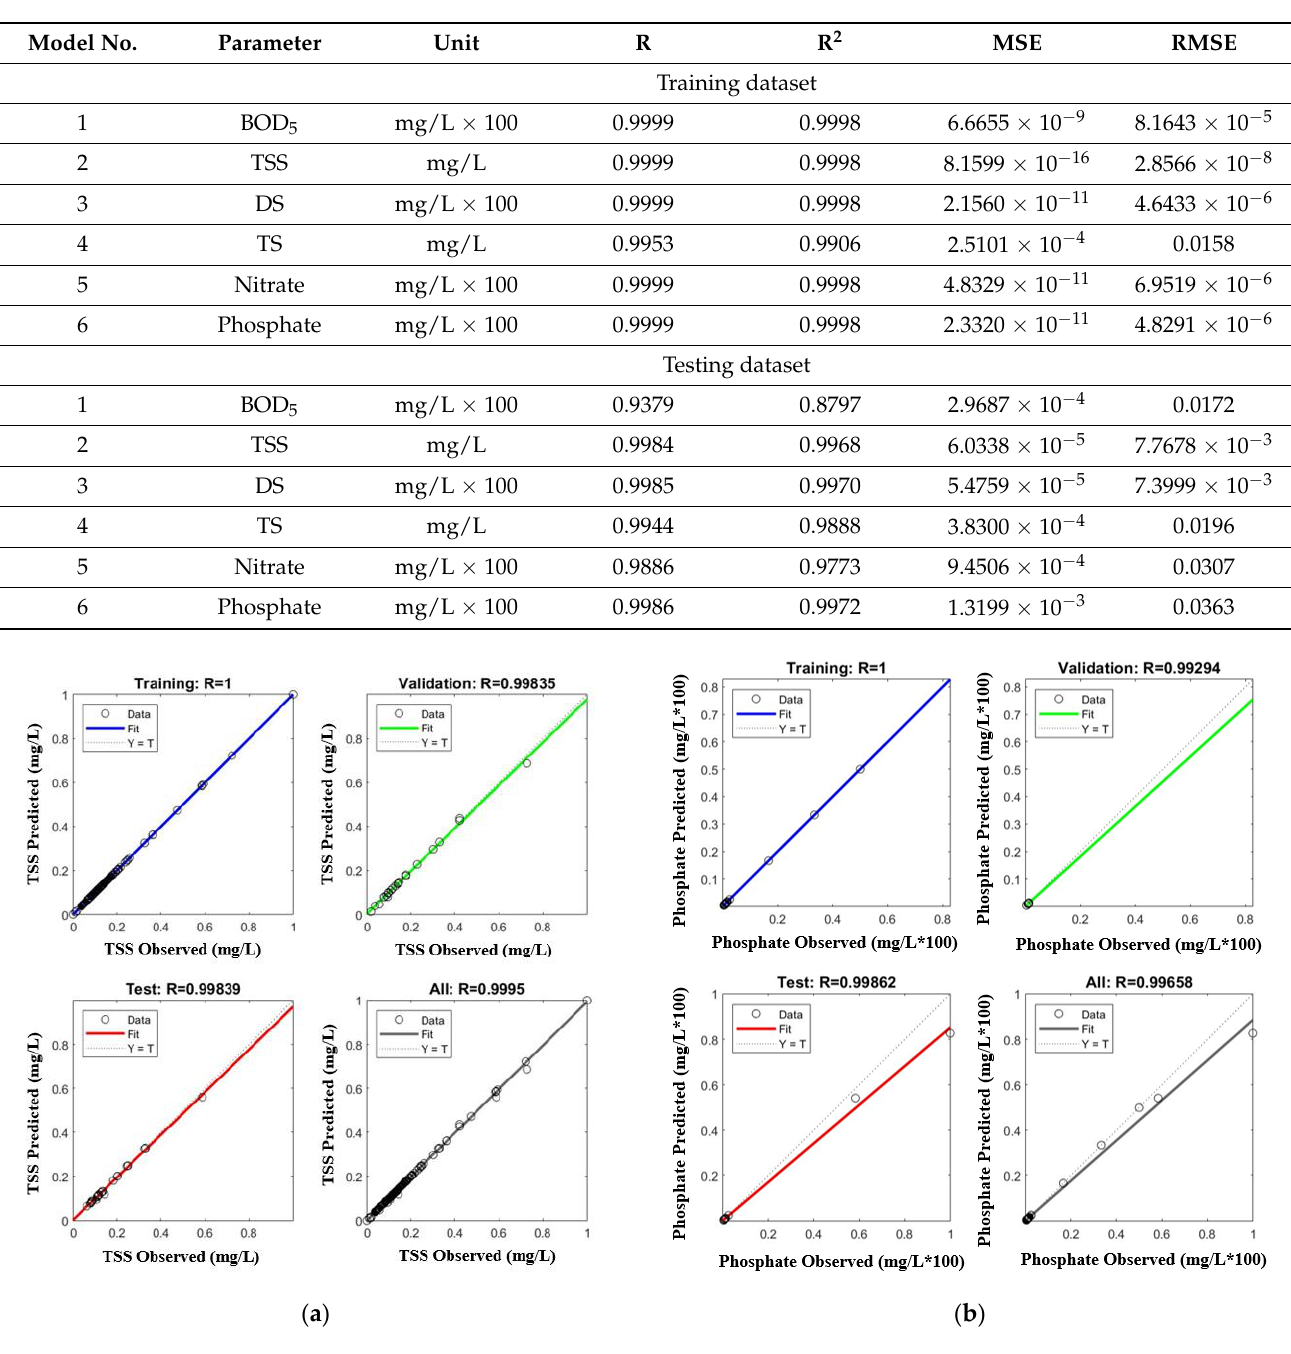
Table 1. Prediction analysis for all models (training and testing datasets).